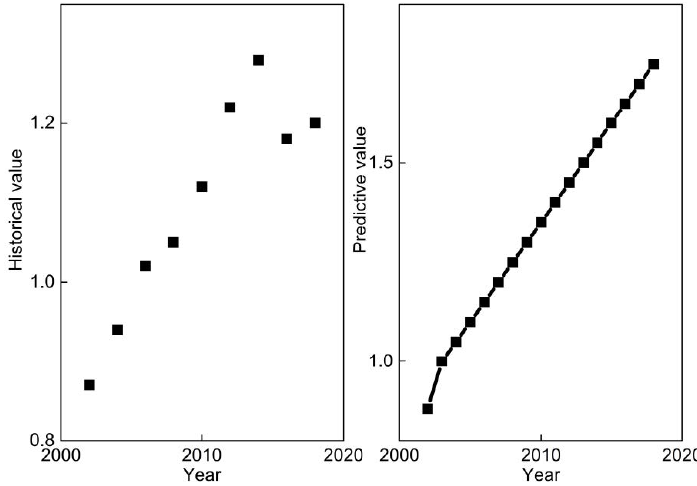
Fig. 8 Comparison of grey forecast results of total energy